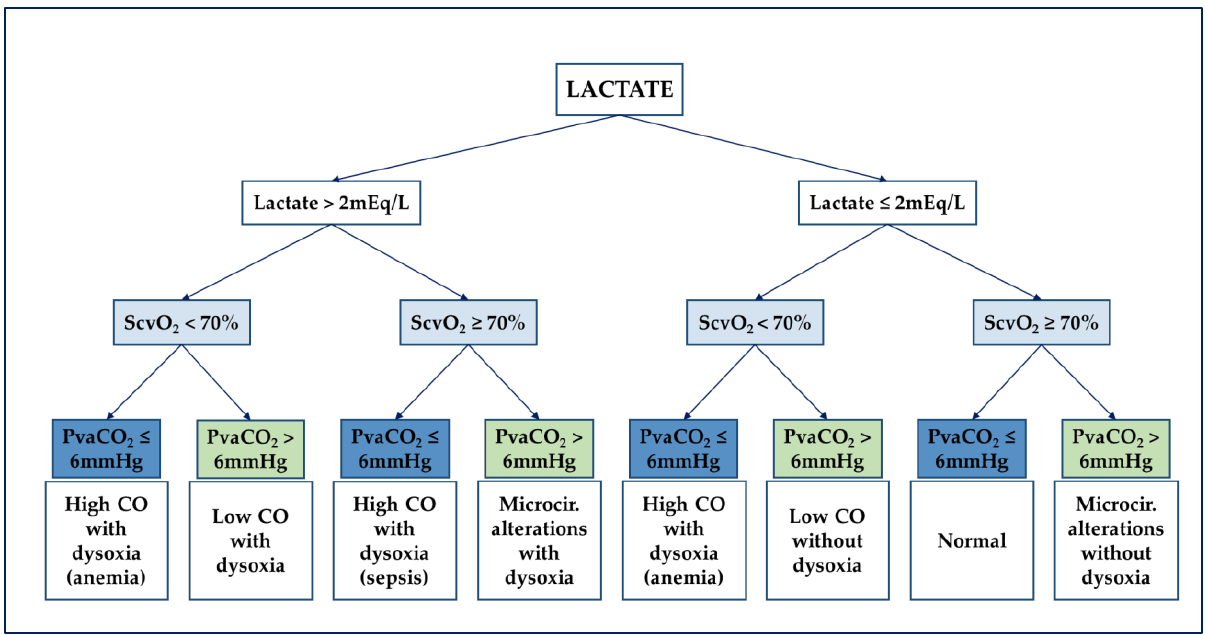
Figure 2. Flow chart for analyzing the hemodynamic profile according to De Backer. ScvO 2 , central venous oxygen saturation; CO, cardiac output; Microcir, microcirculatory; PvaCO 2 , venous-to-arterial carbon dioxide partial pressure difference. Reproduced with permission